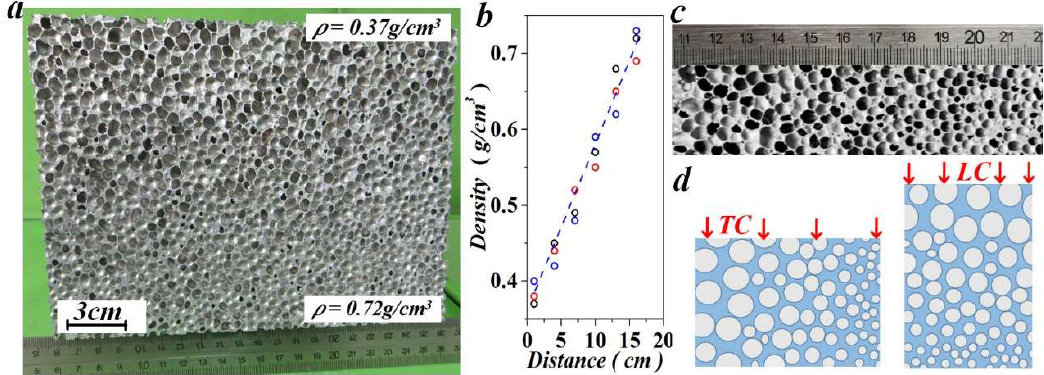
Figure 1. Variation trend of ( a – c ) cell structure and density of functionally density graded (FG) aluminum foam and ( d ), the illustration for the transverse compression (TC) and longitudinal compression (LC).